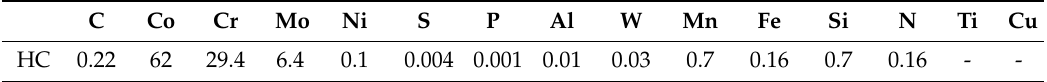
Table 6. Chemical composition (wt %) of High Carbon CoCr alloy (HCCoCr).